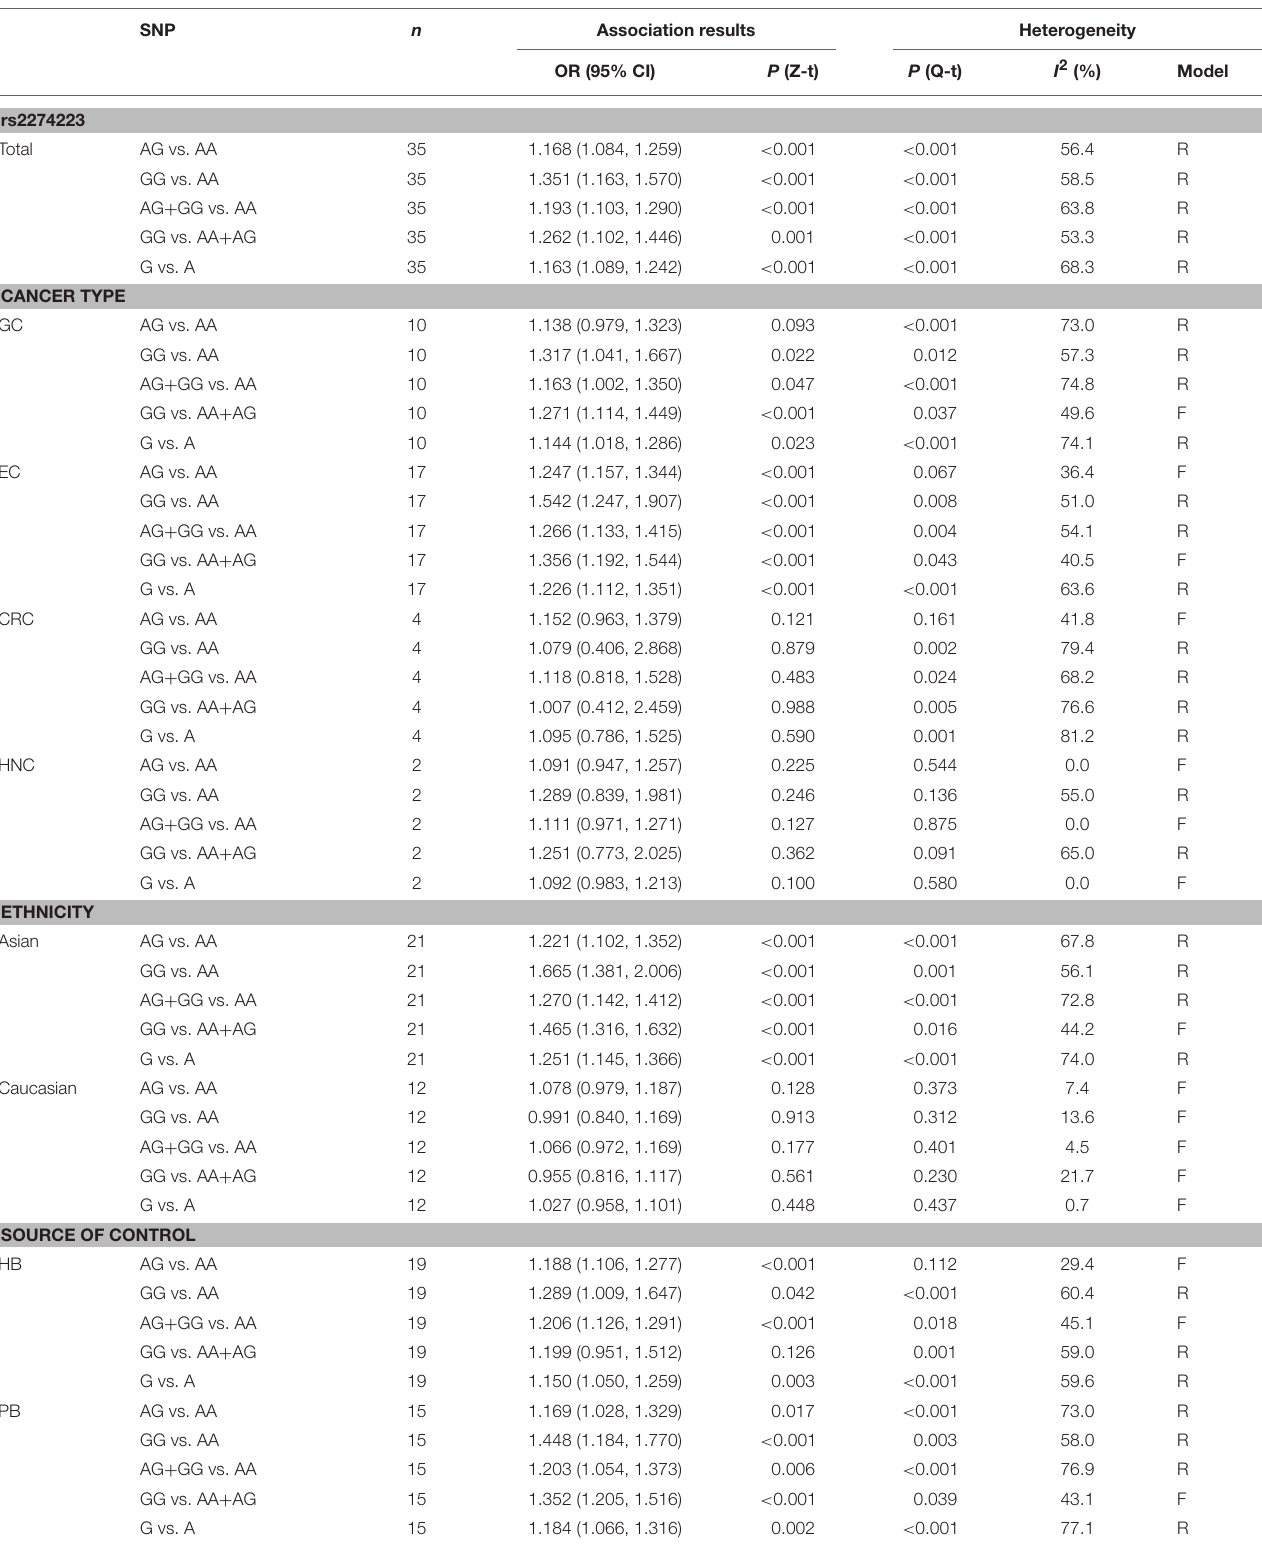
TABLE 2 | Meta-analysis of the relationship between PLCE1 rs2274223 polymorphism and cancer risk. SNP n Association results Heterogeneity OR (95% CI)